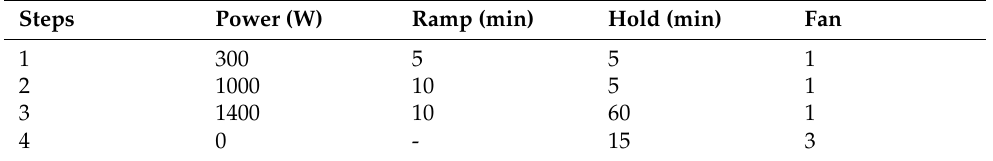
Table 1. Heating program of microwave digestion system for hydrothermal treatment of TiO 2